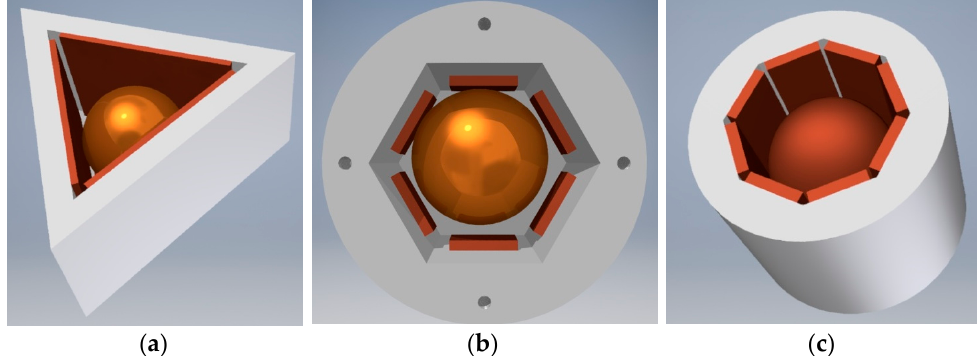
Figure 8. Sensor with six detection sub-ranges: ( a ) the structure; ( b ) principle of operation.